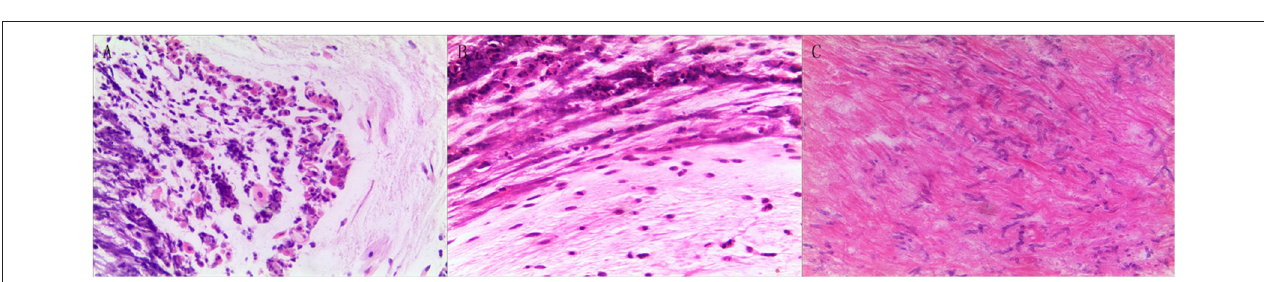
FIGURE 2 | Trancheal bronchoscopy images for the three cases. (A,B) Cases 1 (A1,A2) and 2 (B1,B2) showed substantial purulent secretion and necrotic mucosa. (C) Case 3 showed necrotic mucosa during acute phase (C1) and irregularly shaped trachea and granulation during the recovery phase (C2) .